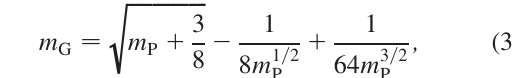
given in Eq. (31), because CIC CDS 2